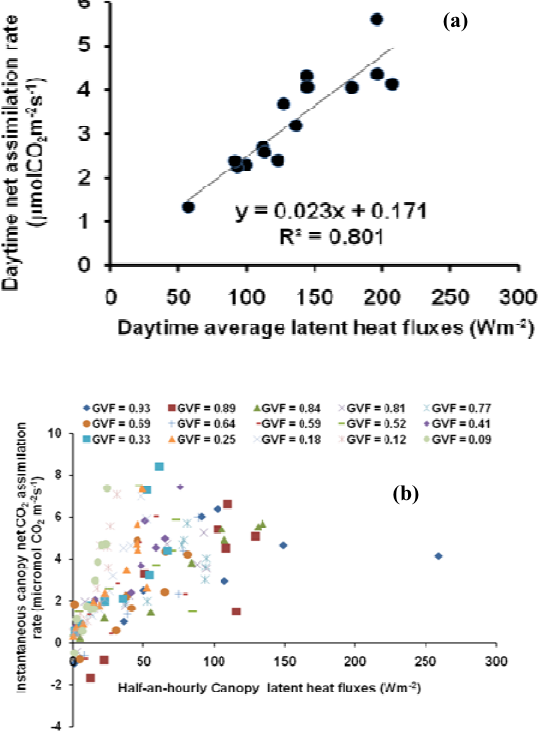
Figure 4. Latent heat fluxes vs. photosynthesis for (a) daytime average and (b) for diurnal instances at different green vegetation fraction (GVF)